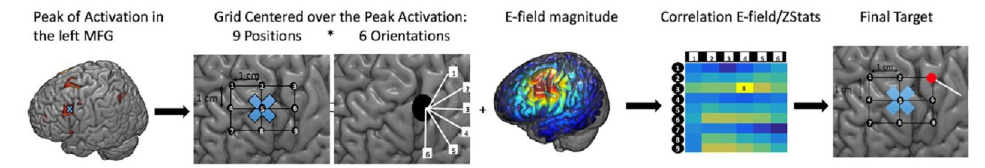
Fig 4. TMS targeting procedure illustrated. From left to right: Peak BOLD activation (1 < z < 3) on the left DLPFC associated with increasing set size; E-field grid with 3 × 3 positions and 6 coil orientations centered at the peak BOLD activation; representation of the E-field magnitude for one of the 54 options; correlation matrix between E-field magnitude for each of the 54 options and the activation z-values in which the highest correlation is for position 3 and orientation 4; optimized rTMS coil location (red dot) and orientation (white